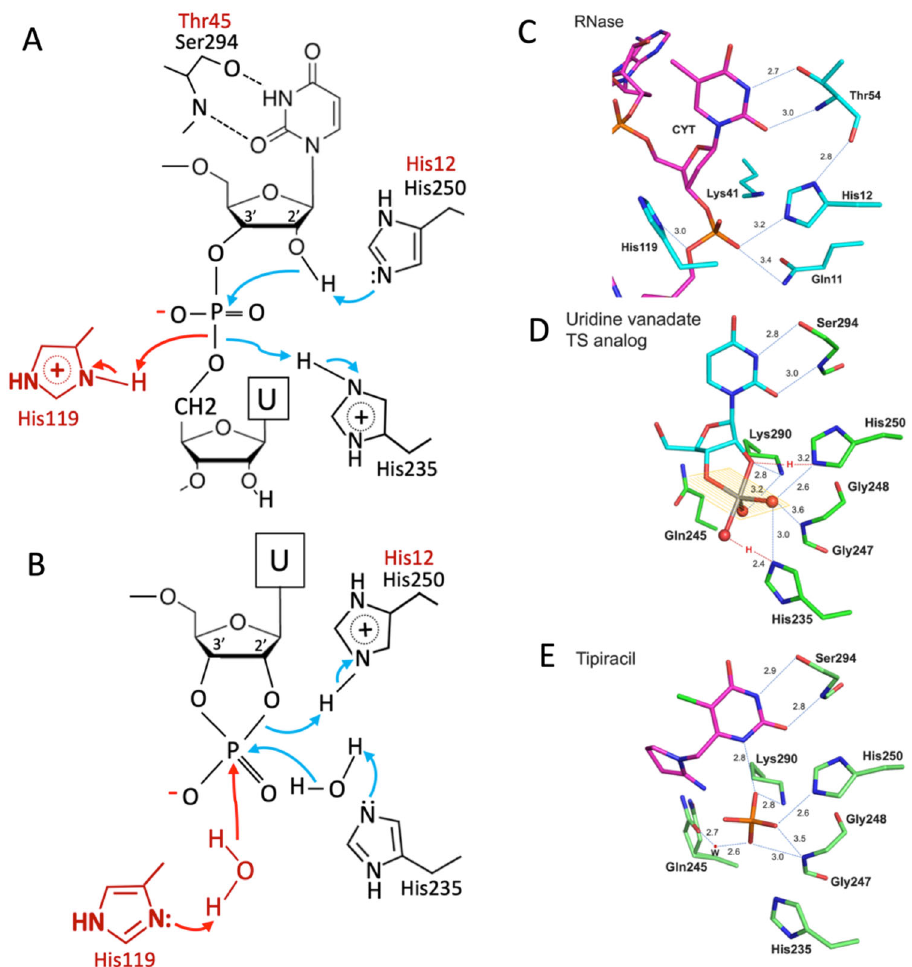
Fig. 6 The reaction mechanism and comparison of Nsp15 and RNase A active sites. A , B Schematic drawings of reaction mechanism of Nsp15. A Transphosphorylation reaction that generates 2 ′ ,3 ′ -cyclic phosphodiester. B Hydrolysis reaction from transition state. Residues shown in red are for RNase A and in black for Nsp15. Arrows depict electron transfer. The active site of RNase A ( C ) is compared with that of Nsp15 in the complex with transition state analog uridine 2 ′ ,3 ′ -vanadate ( D ), and with Tipiracil ( E ). The transition state of the phosphate is present in both reactions.